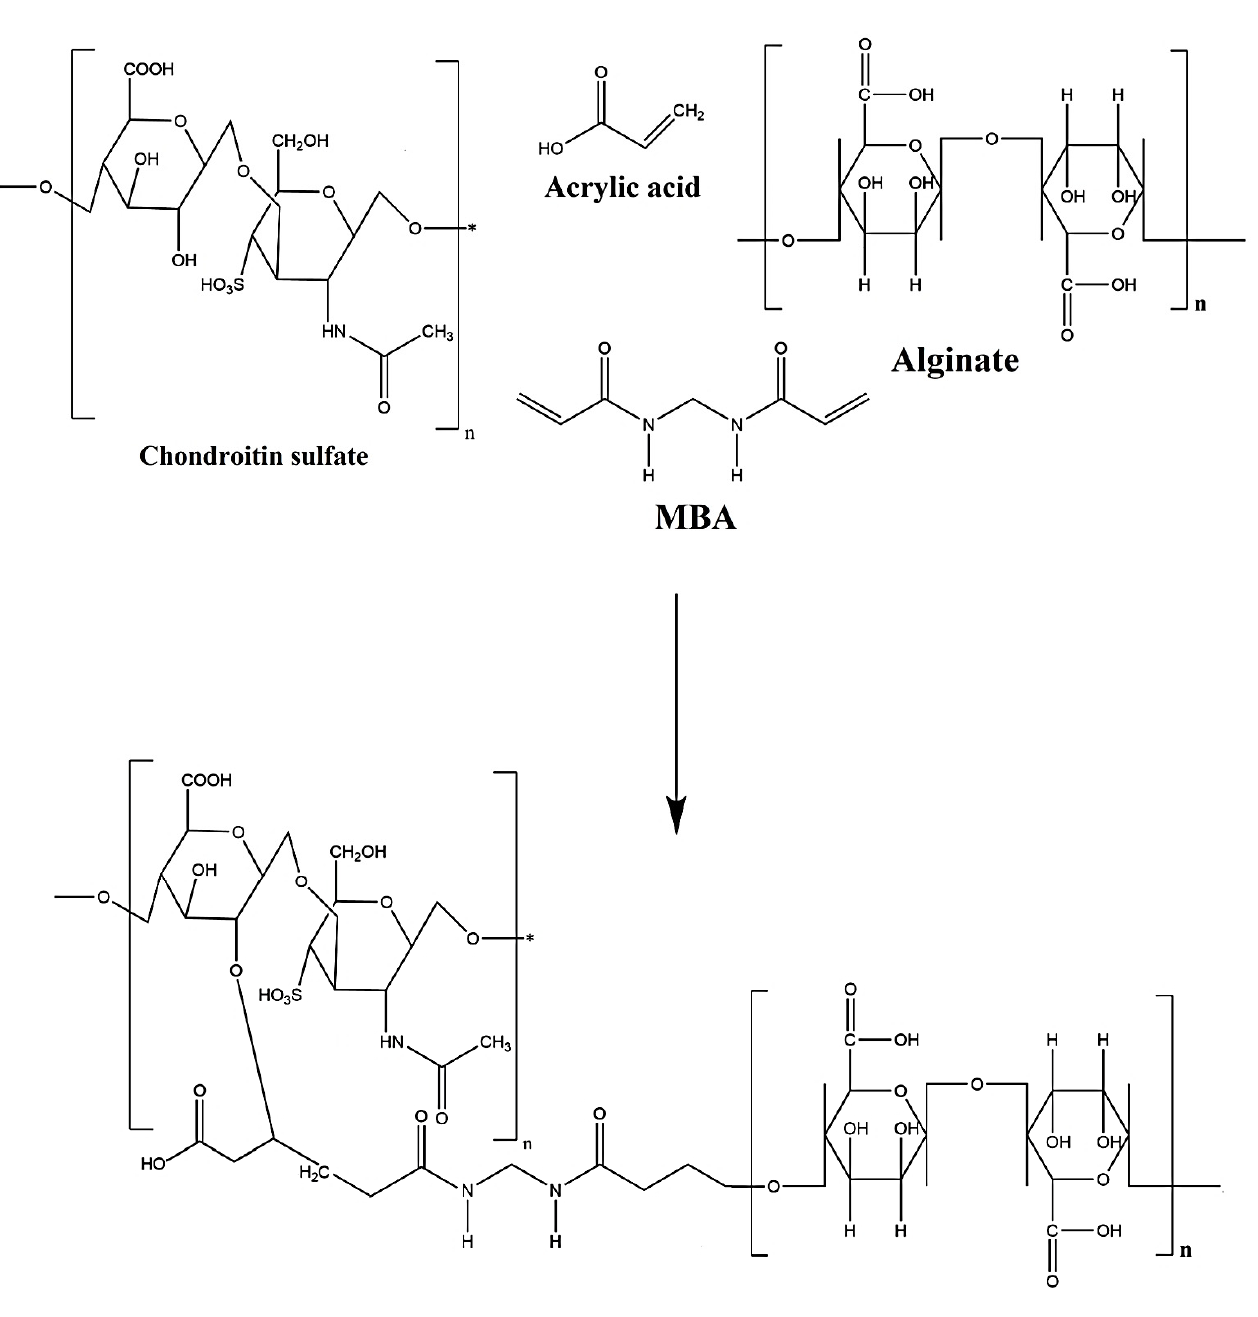
Figure 1. Proposed chemical structure of CS/Al-g-pAa hydrogel.